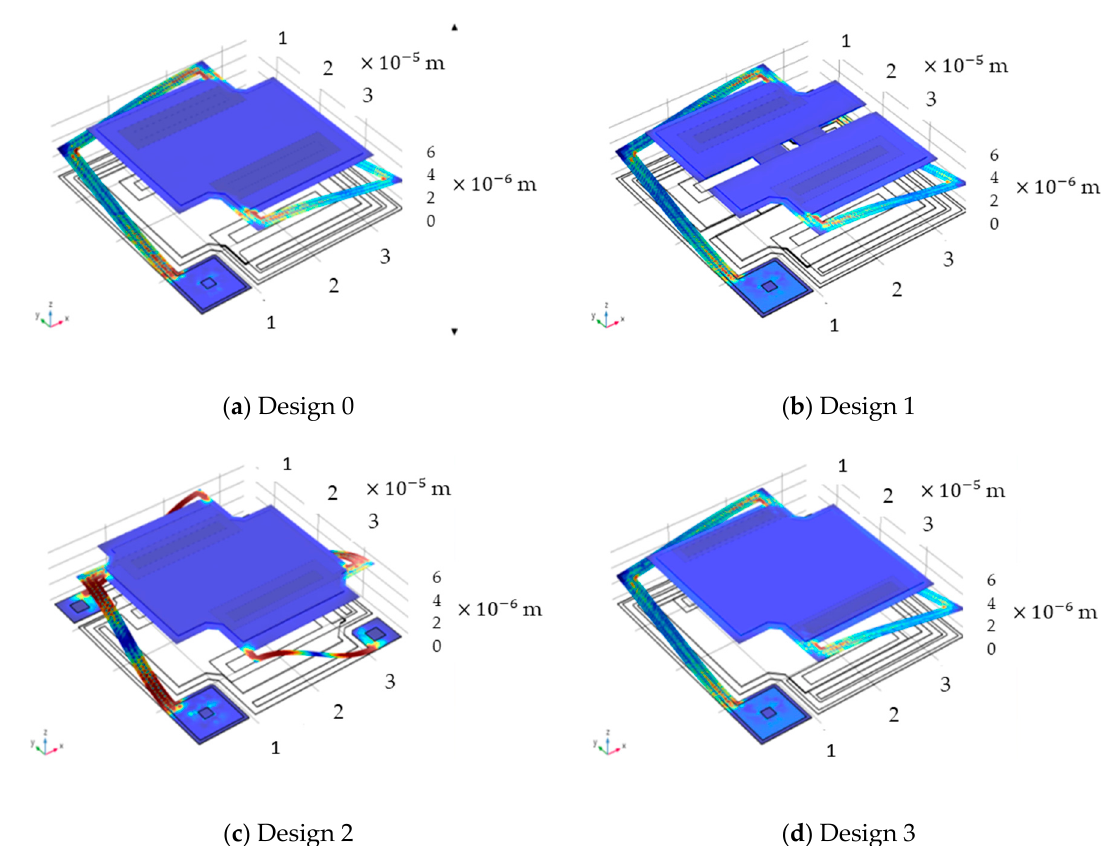
Figure 2. The 4 kinds of top-view 3D geometric 35 μ m pixel pitch single-element microbolometer structures, where ( a ) Design 0 is the standard L-shaped dual-leg structure for reference; ( b ) Design 1 with 2 μ m × 2 μ m central square hole and two 7.5 μ m × 2 μ m slits on the suspended area; ( c ) Design 2 with 4-leg structure used for strengthen the suspended supporting and ( d ) Design 3 is the structure with increasing the gap between two contacts, from 14.5 to 20.5 μ m.